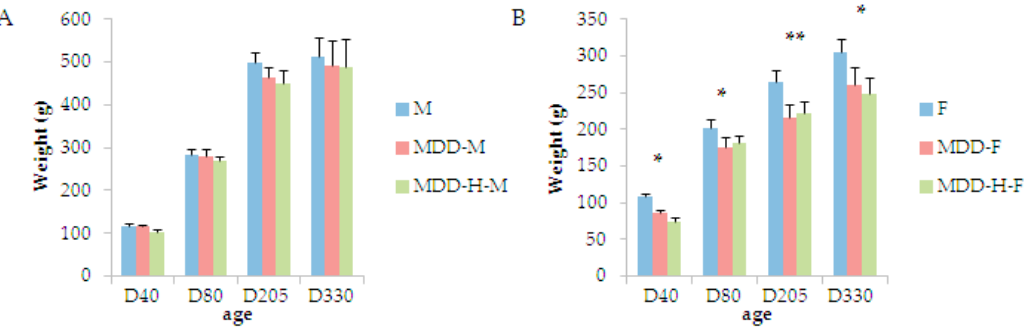
Figure 1. Body weights in grams of growing ( A ) male (M) and ( B ) female (F) rats after weaning (21 days of age) and the switch from the deficient (MDD for methyl donors deficiency) to the normal diet (H represent neonatal mild transient Hypoxia, n = 10 to 15 animals per group). Statistics, * p < 0.05, ** p < 0.01.